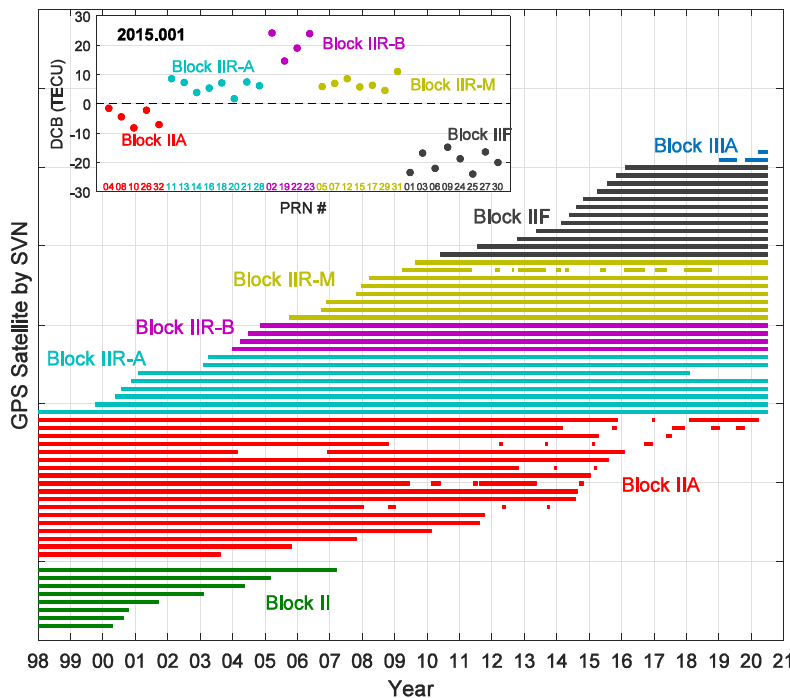
Figure 2. Lifetime of each GPS satellite sorted by Space Vehicle Number (SVN) from 1998 to 2020. Different colors denote different satellite block series. The GPS DCBs on 1 January 2015 are displayed on the upper left corner in the figure, with the corresponding PRNs shown at the bottom.